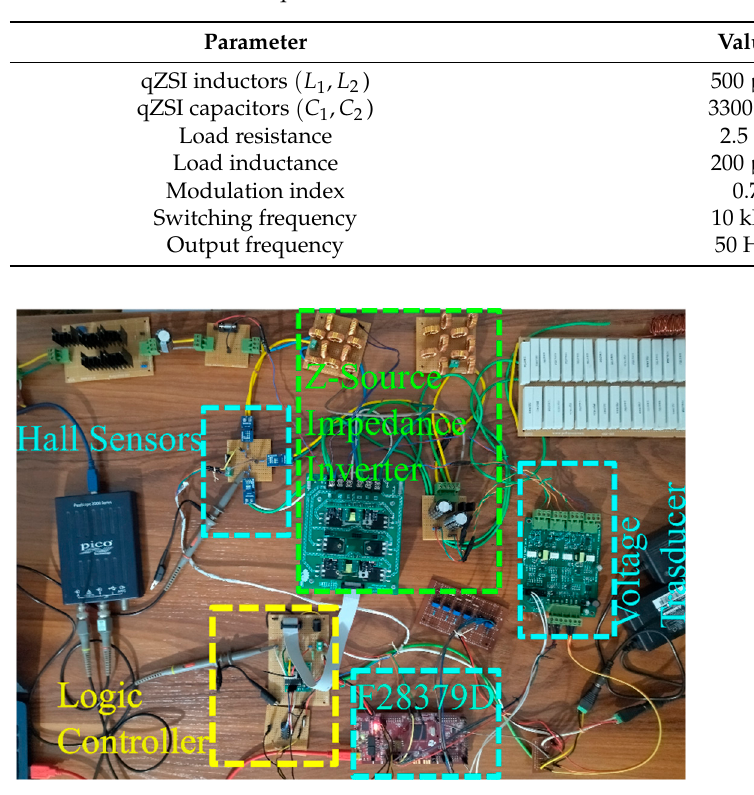
Figure 6. Overall block diagram of the control system. Table 1. Parameters of the qZSI.